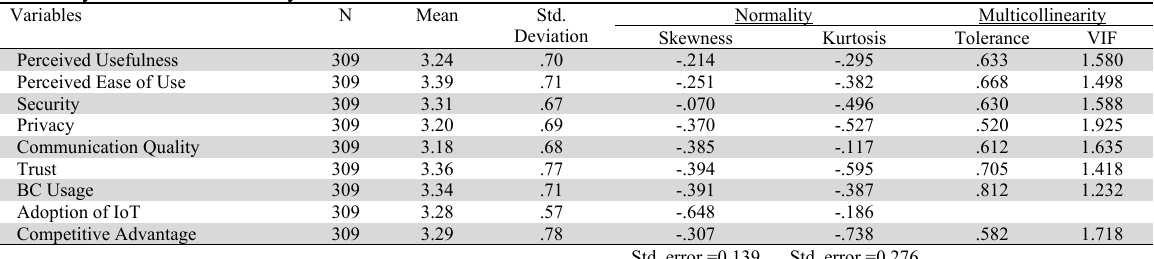
Normality and Multicollinearity Variables